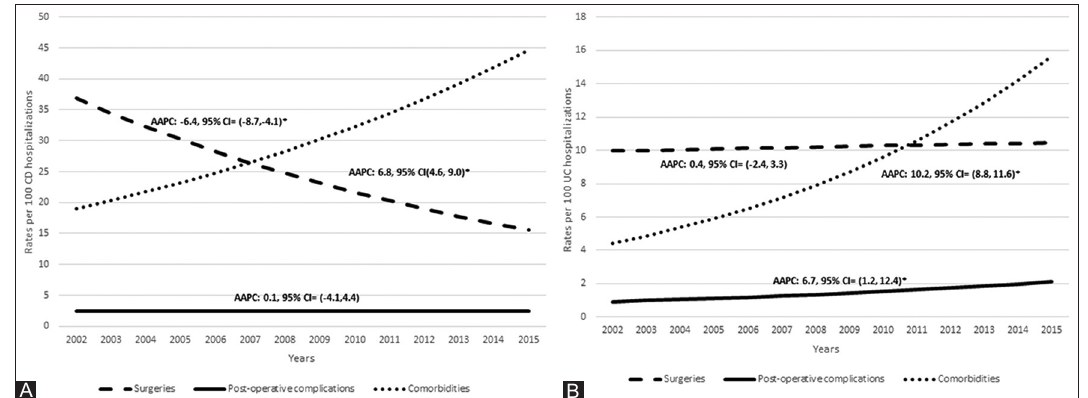
Supplemental Figure 1: Rates of surgeries, post-operative complications and comorbidities per 100 Crohn’s disease [CD] (A) and ulcerative colitis [UC] (B) hospitalizations AAPC= Average Annual Percent Change. *p≤0.05